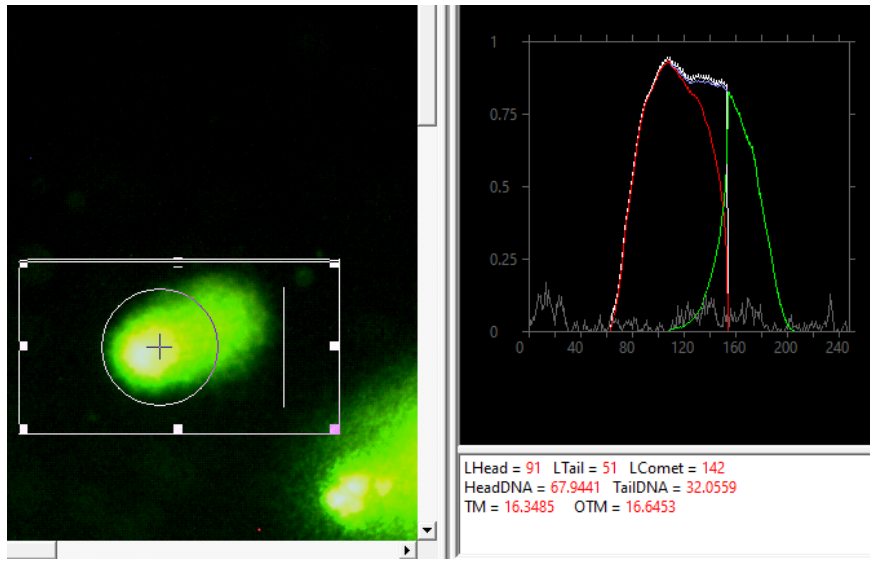
Figure 2. “DNA-comet tail” length calculation using the Casplab_1.2.3b2 software. During electrophoresis, DNA fragments torn away from the main molecule leave the nucleus and create the “comet tail”. Therefore, the percentage of the DNA in the tail was considered proportional to the damage to the